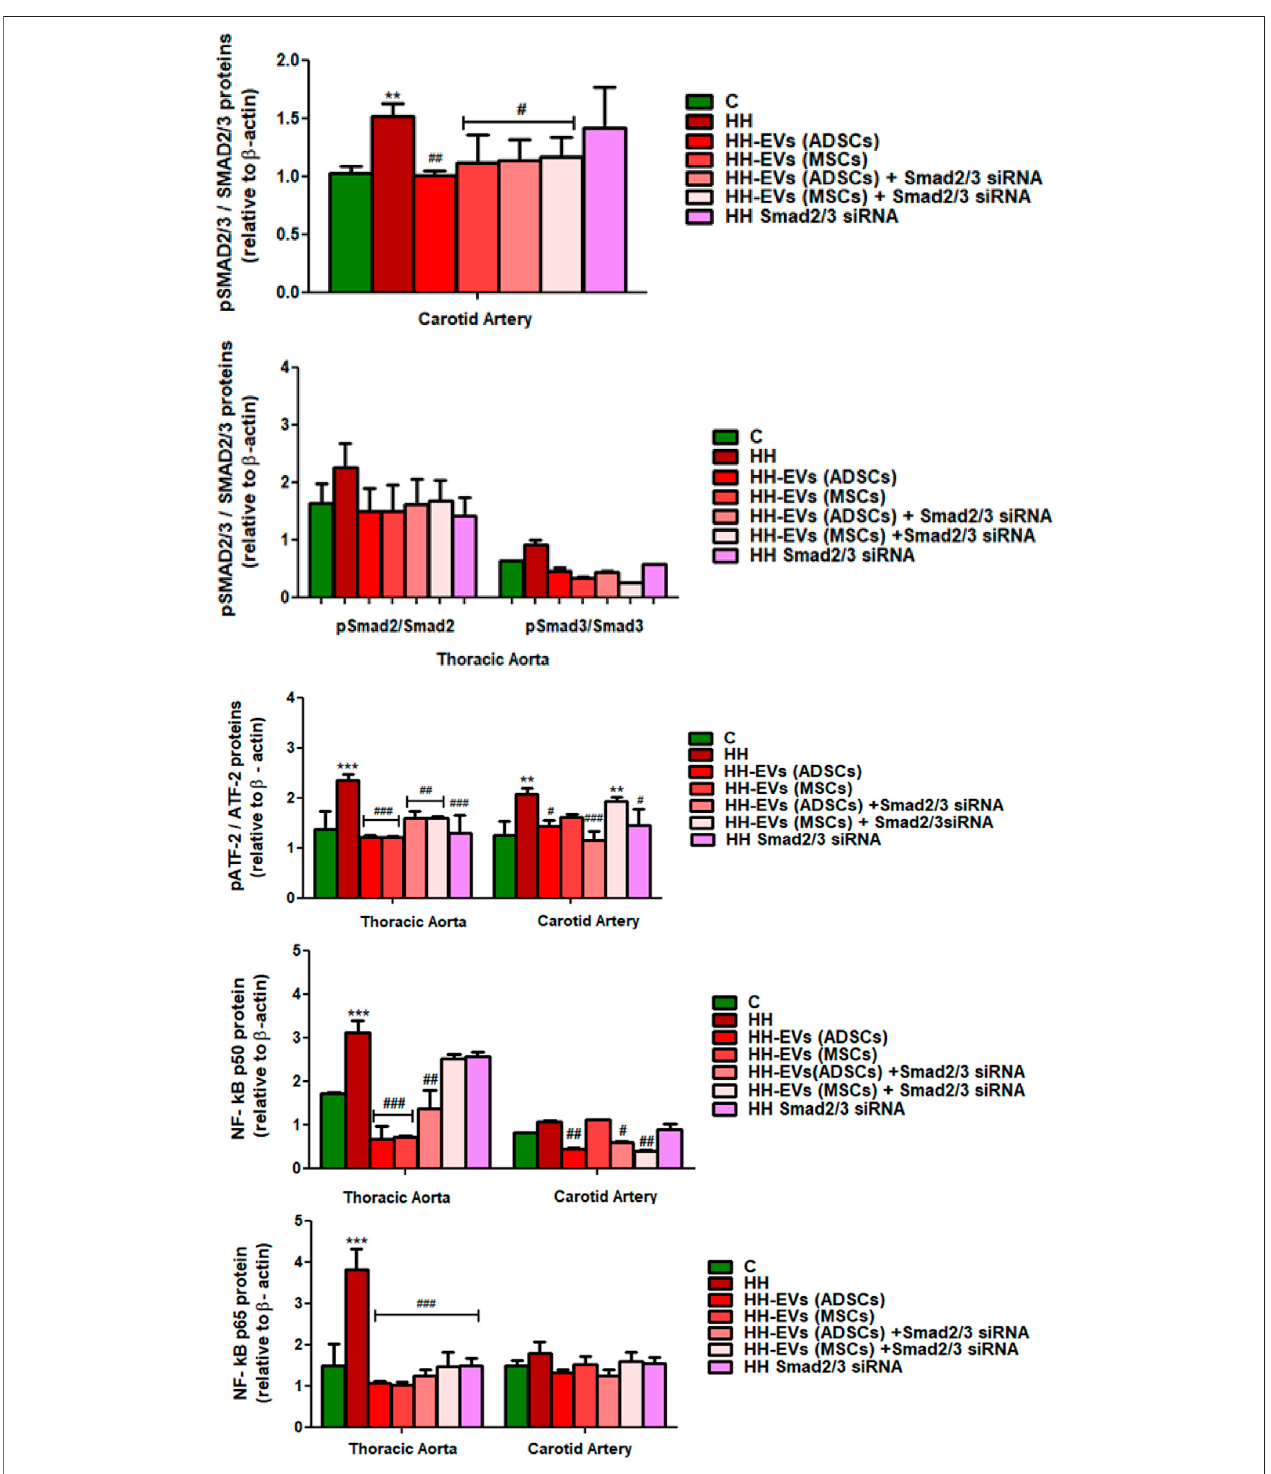
FIGURE 11 | Western Blot analysis for relative expression of speci fi c pro-in fl ammatory molecules (proteins): pATF-2, ATF-2, pSMAD2/3, SMAD2/3, and NF- kBp50/p65.Histogramsshowaquantitative representationoftheproteinlevelsobtainedfromallinvestigated groupsoffourindependentexperimentsafter4 monthsof diet and treatment. Each value represents the mean ± SD. The statistical signi fi cance, noticeably different, was represented as *** p < 0.005, ** p < 0.01 values versus controlgroupand ### p < 0.005, ## p < 0.01, # p < 0.05valuesversusHHgroup.Statisticalanalysiswasconductedusingtwo-wayANOVAandBonferronipost-test. The gray intensity of related proteins was analyzed by the TotalLab TL120 program. The housekeeping β -actin protein was used as an internal control for protein normalization and monitor for equal loading. Note that the β -actin expression fl uctuated upon the treatment or under physiological and pathological conditions.